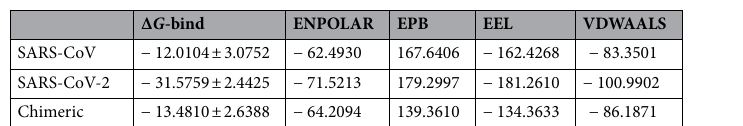
Table 2. The MM-PBSA binding energies (kcal·mol −1 ) for the three spike-receptor structures.